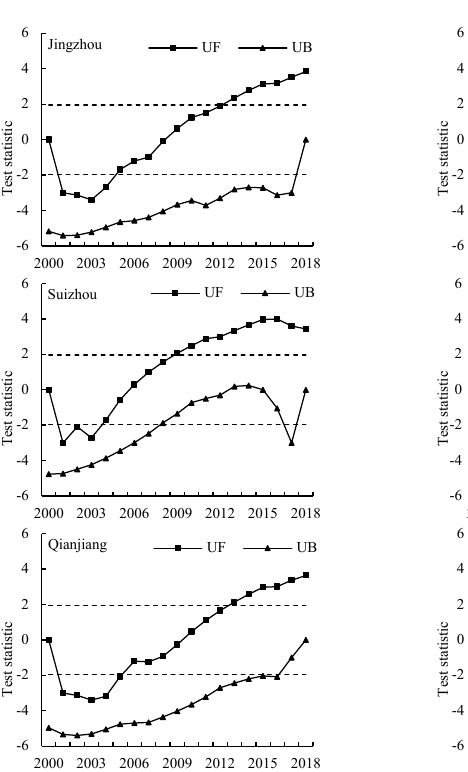
Figure 7. Trend variation and abrupt change test for grain yield between 2000 and 2018. The horizontal dashed lines represent the critical values of the 0.05 significance level.